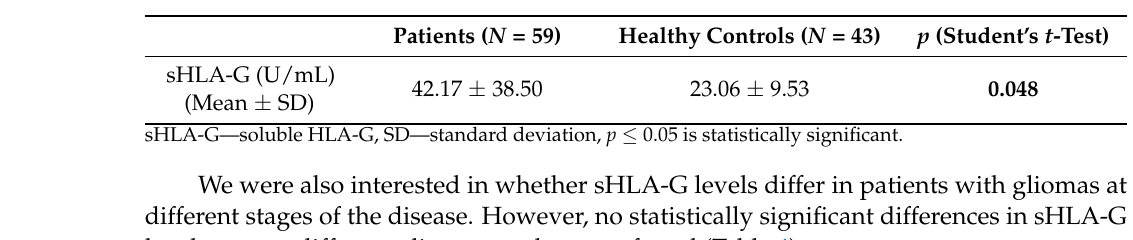
Table 3. The plasma level of sHLA-G in glioma patients and healthy controls.